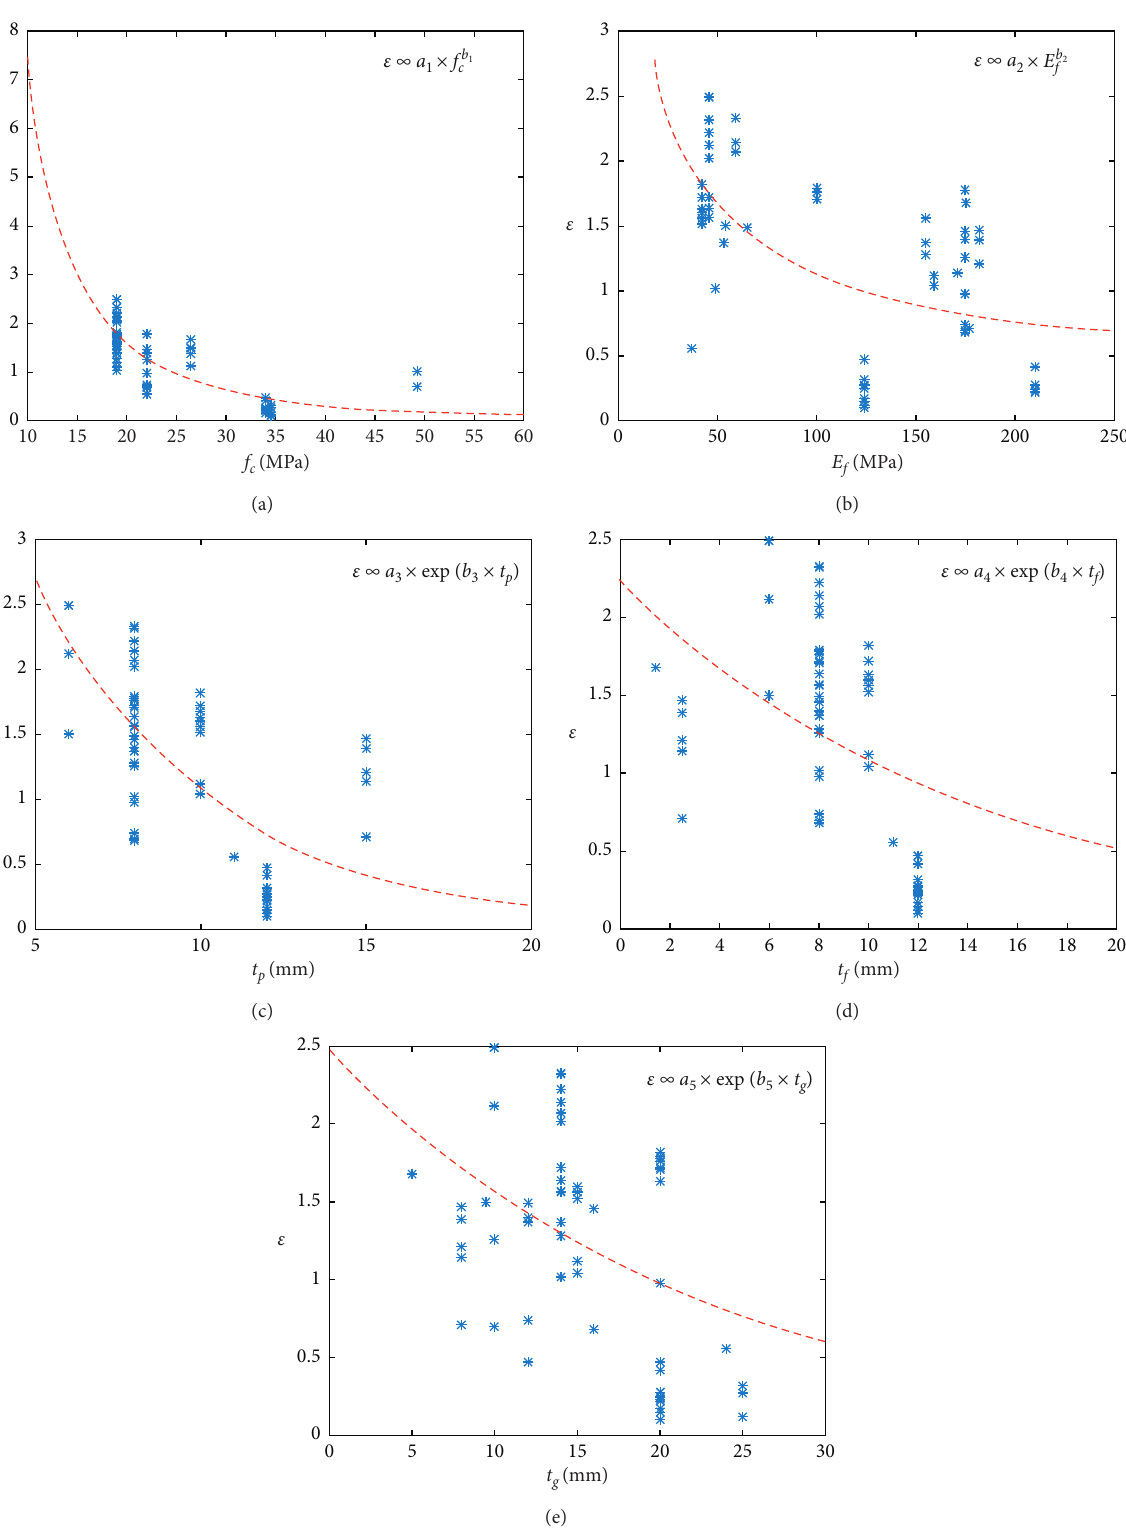
Figure 7: Fitting function graph: (a) concrete compression strength, (b) FRP modulus of elasticity, (c) FRP height, (d) FRP thickness, and (e) groove